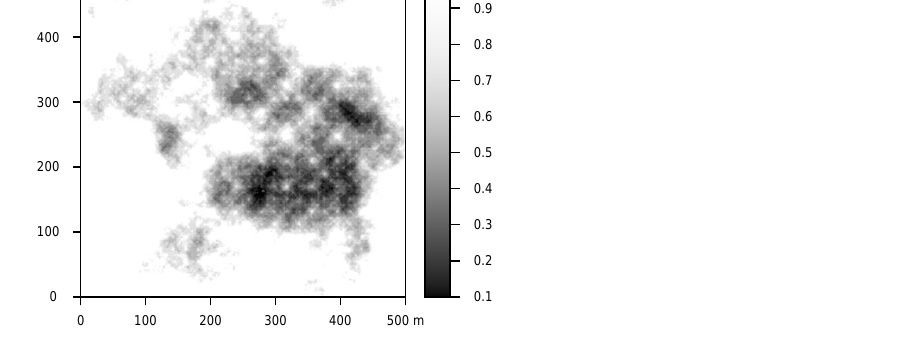
Figure 4. A synthesized image of studied cloud. Reprinted/adapted with permission from Ref. [22]. 2020, Chen et